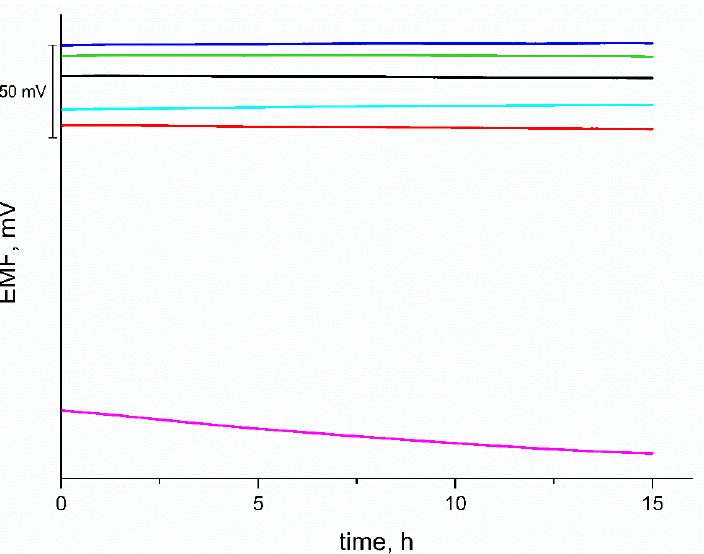
Figure 4. Potentiometric response of the GC/eCNF/K + -ISM (blue), GC/eCNF-Co/K + -ISM (cyan), GC/eCNF/CNT[HD]-Co/K + -ISM (green), GC/eCNF/CNT[HD]-NiCo/K + -ISM (black), GC/eCNF/CNT[LD]-NiCo/K + -ISM (red) and coated disc electrode (magenta) measured over 20 h after 72 h of conditioning.